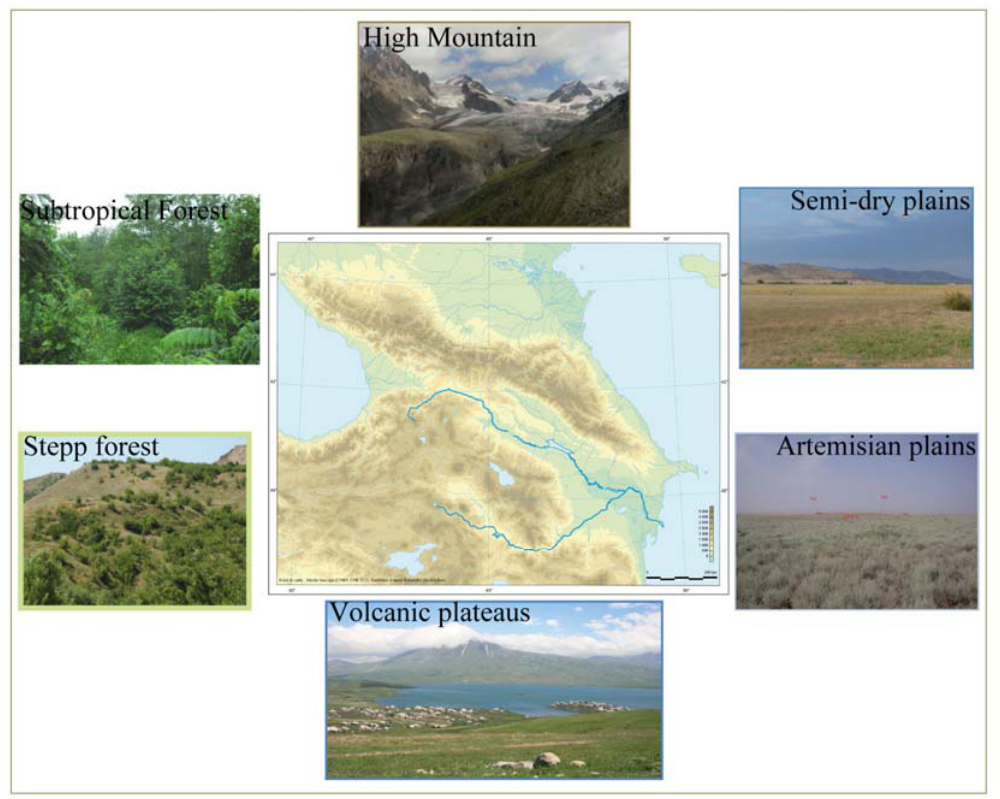
Figure 1. The different landscapes and environments in South Caucasus: to the North high mountainous landscapes, to the South volcanic plateaus, to the West subtropical forests and step forests on the piedmont, to the East semi-dry and artemisian